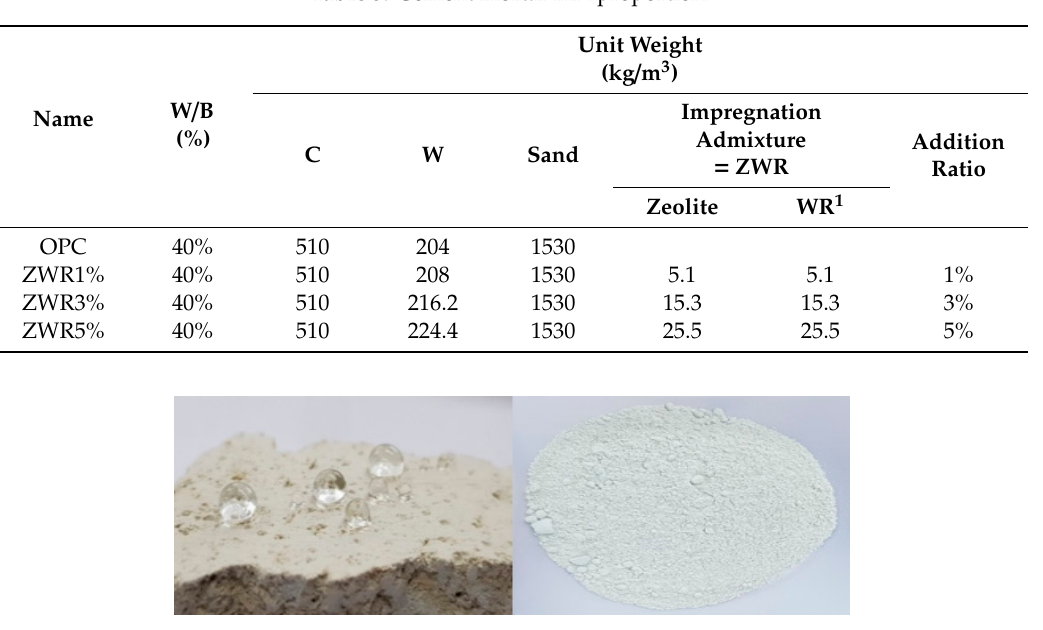
Table 5. Cement mortar mix proportion .